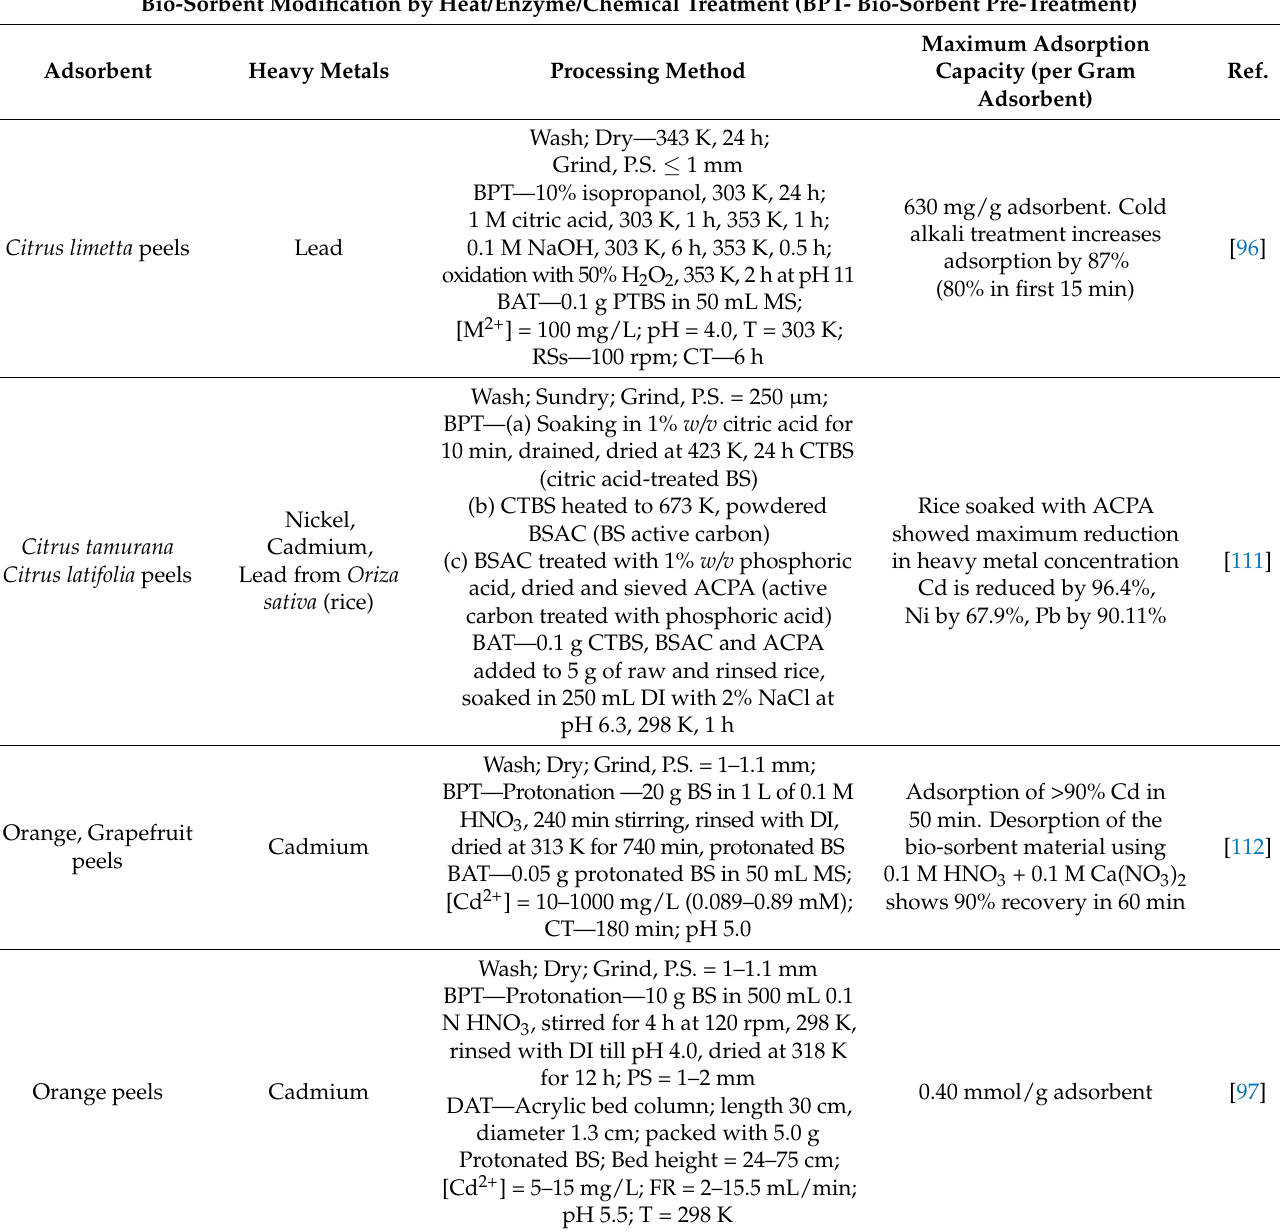
Table 3. Citrus waste-derived bio-sorbents via heat/chemical and enzyme pre-treatment for removal of heavy metals from